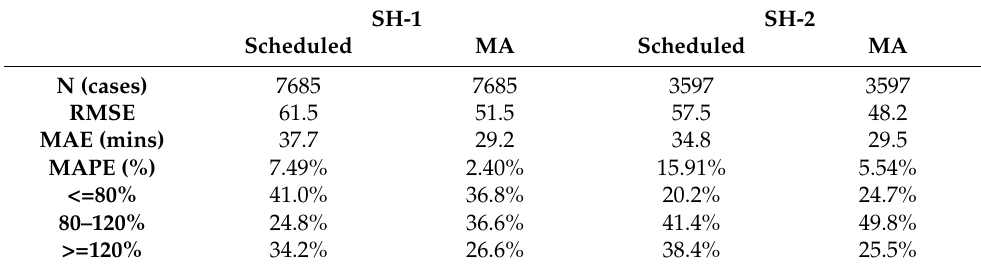
Table 3. Performance of scheduled vs. MA duration.